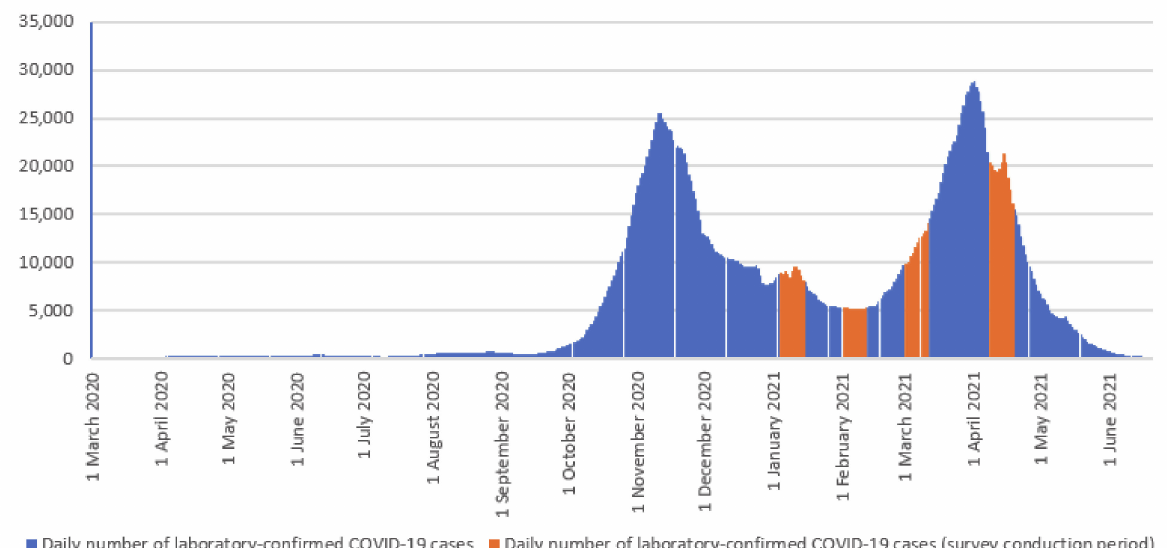
Figure 2. Daily number of laboratory-confirmed COVID-19 cases in Poland, March 2020–June 2021 (rolling 7-day